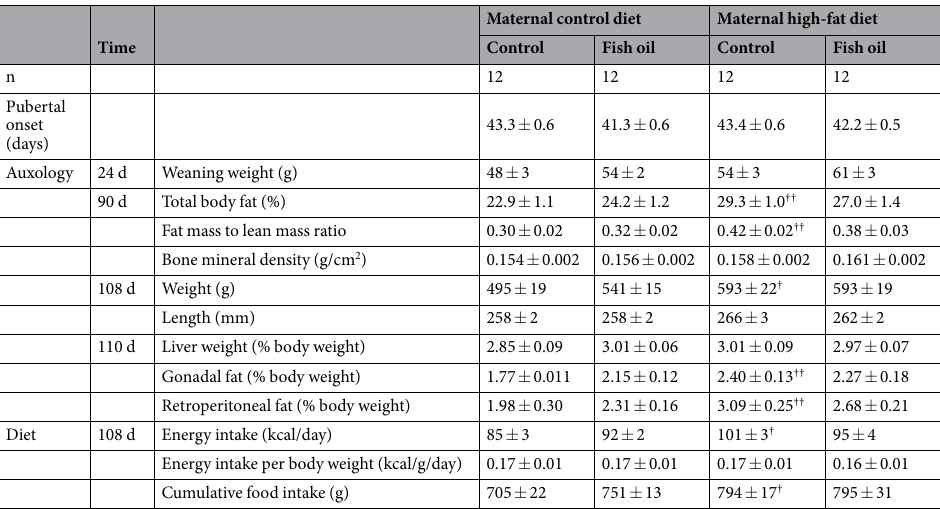
Table 4. Study outcomes among male offspring according to the maternal diet (control or high-fat) and the gavage treatment during pregnancy [fish oil or control (water)]. “Cumulative food intake” reflects the weight of all food consumed by an individual rat since weaning. Data are means ± standard errors. † p < 0.05 and †† p < 0.01 for a maternal diet effect among the offspring of dams that received control gavage. Note that all study groups consisted of 5 to 7 separate litters. Time represents the age of the animals in